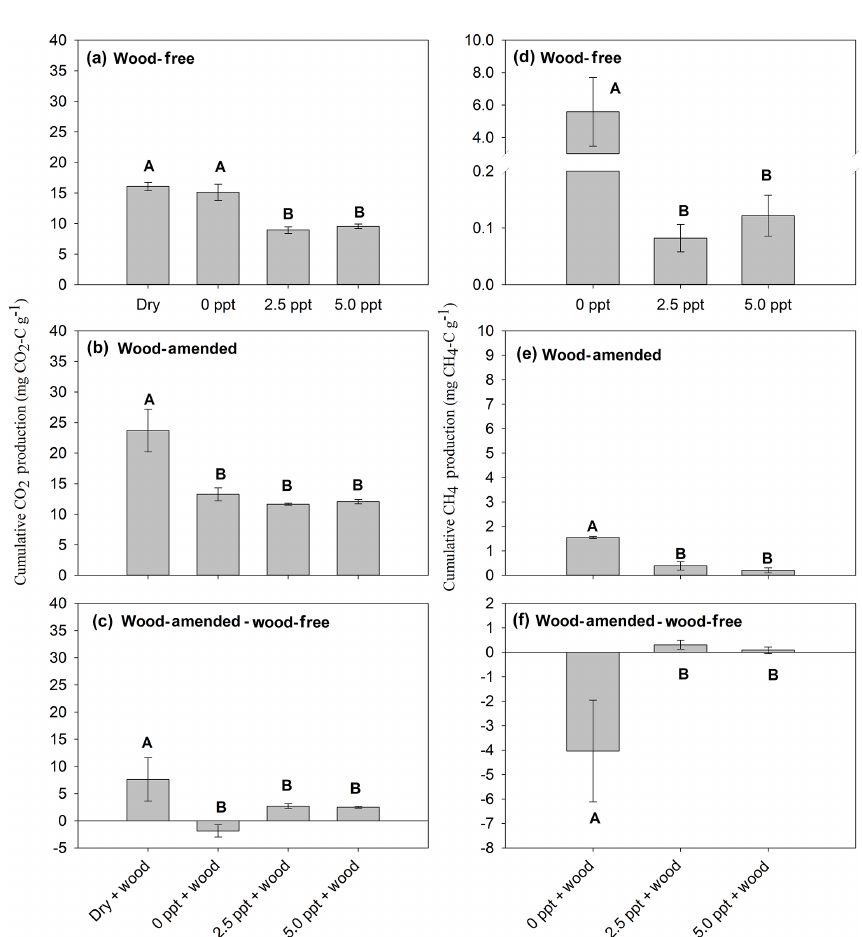
Figure 3. Cumulative CO 2 production from wood-free soils (a) , wood-amended soils (b) , and the wood-associated CO 2 production (c) ; and cumulative CH 4 production for wood-free soils (d) , wood-amended soils (e) , and the wood-associated CH 4 production (f) . Panels (c) and (f) refer to the difference between wood-amended and wood-free soils. Bars represent the mean with standard error ( n = 4). Bars with different uppercase letters are significantly different ( P < 0 .